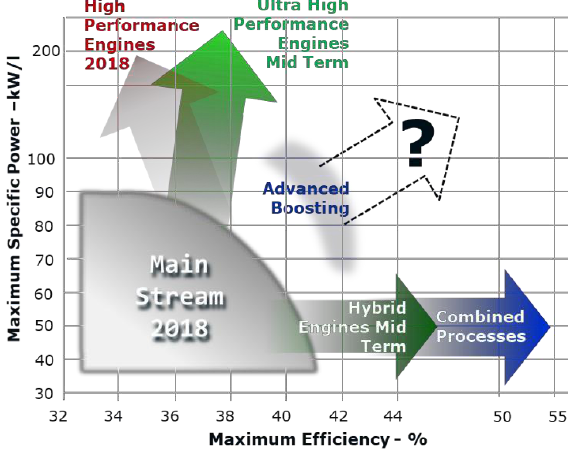
Fig. 15. Trade-off between maximum efficiency and specific power of Gasoline engines